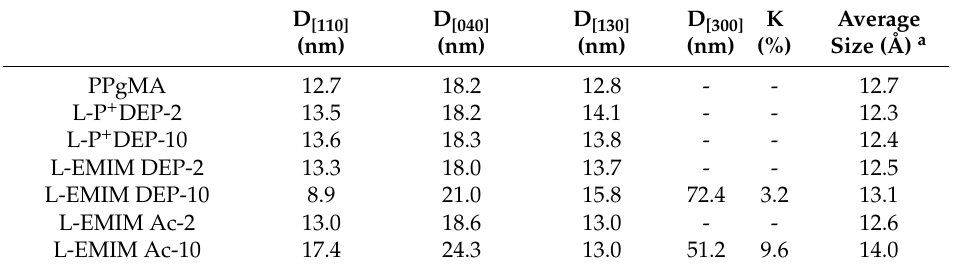
Table 4. XRD analyses of the PPgMA and its related LIonomers (from Figure 9).